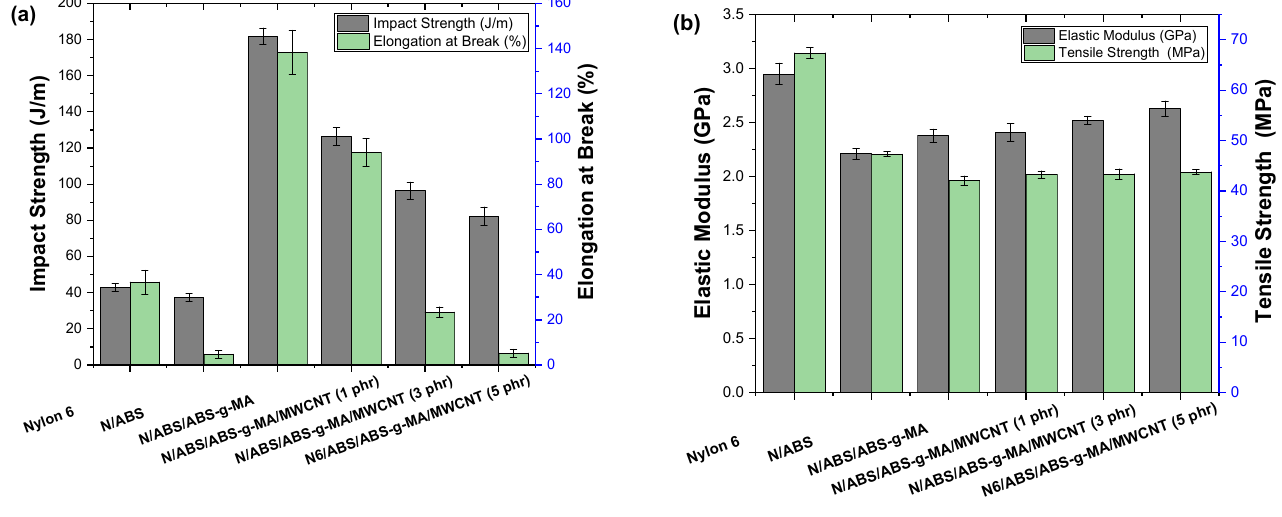
Table 1. Mechanical properties of Nylon 6, blends, and nanocomposites. IS = impact strength; E = elastic modulus; TS = Tensile strength at yielding; EB = elongation at break; N = Nylon 6.